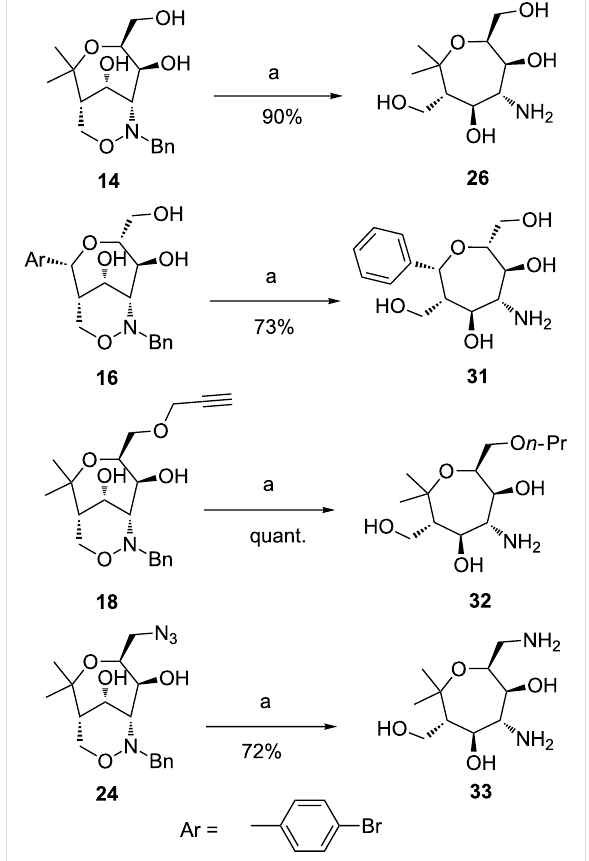
troscopy which shows a small coupling between one proton